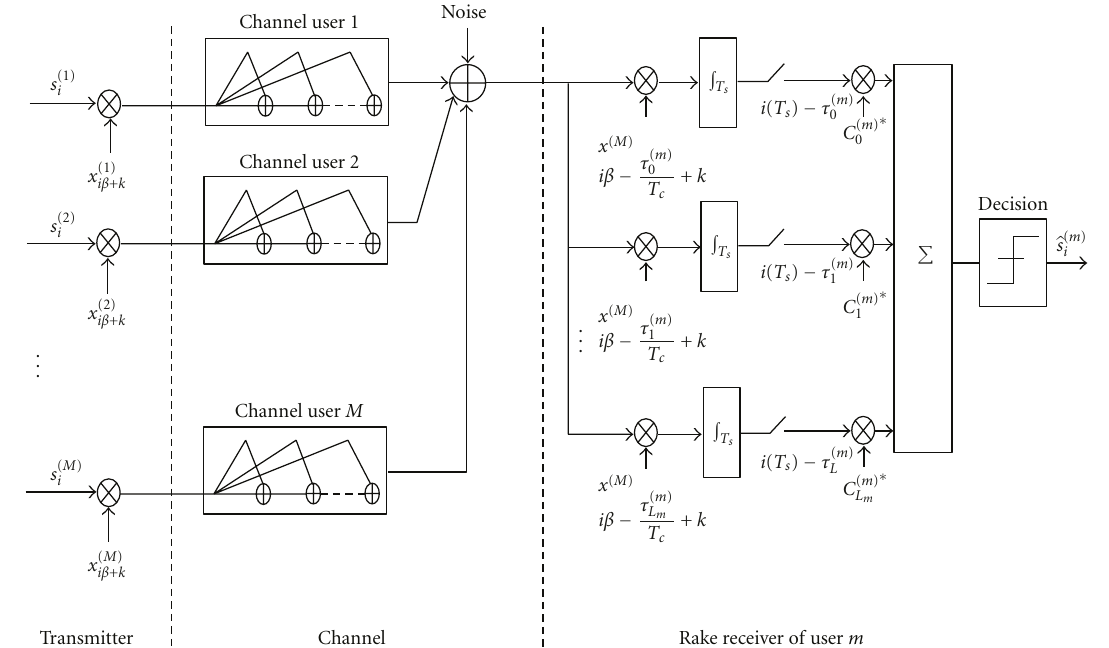
Figure 1: Simplified baseband equivalent of a chaos-based DS-CDMA system with a multipath channel.